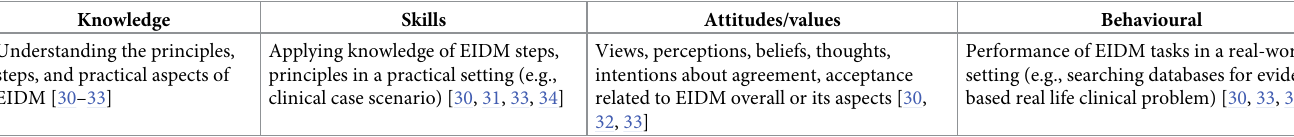
Table 1. EIDM competence attribute